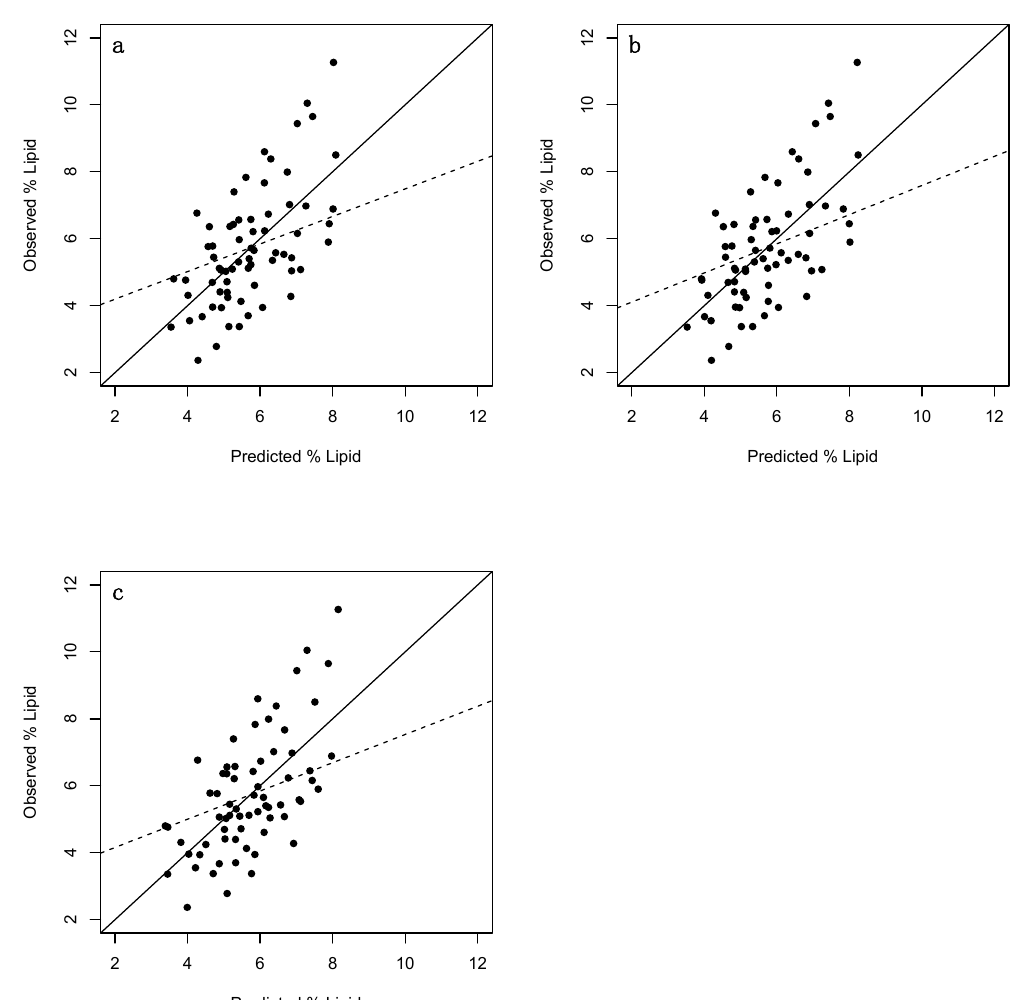
Figure 2. plots of observed vs. predicted percent lipid values of adult Cottus cognatus ( n = 68). ( a ) = Fulton’s condition factor; ( b ) = Fulton’s condition factor excluding stomach content and gonadal mass; ( c ) = Le Cren’s relative condition factor. Solid lines have a slope of 1 and an intercept of 0 thereby representing the ideal scenario where predicted = observed. Dashed lines denote represent linear regression lines.